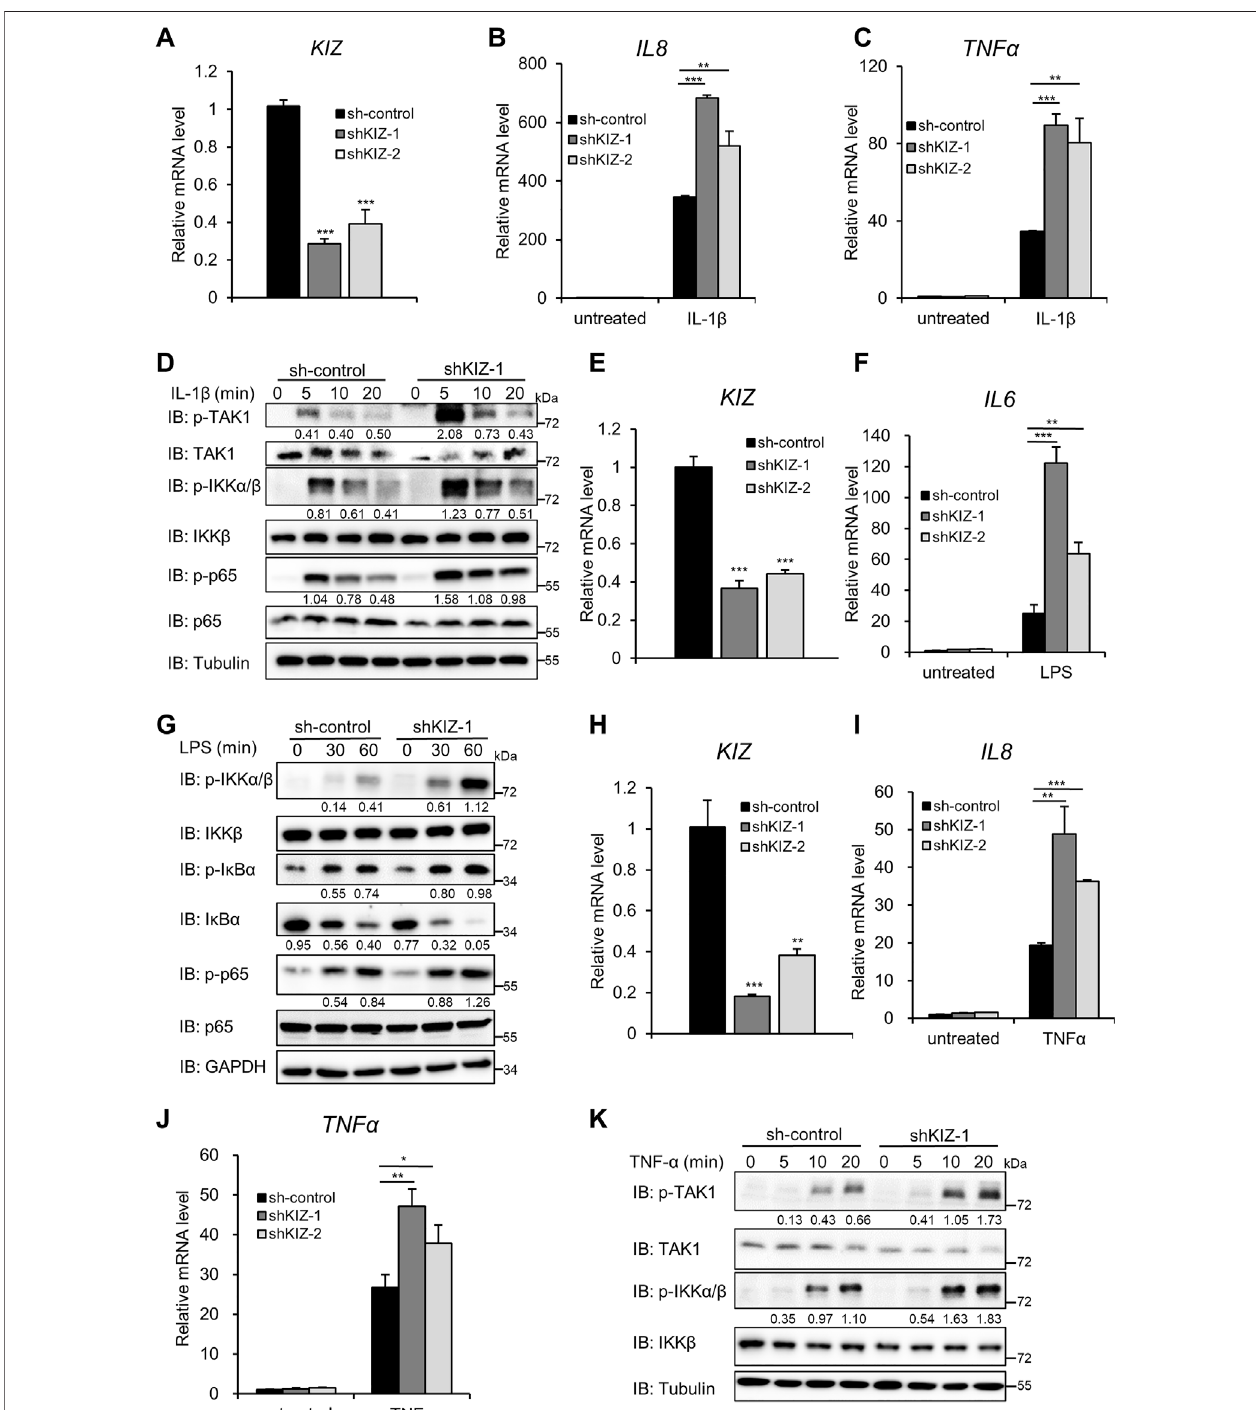
FIGURE 2 | Knockdown of KIZ enhances IL-1 β /LPS/TNF α -induced NF- κ B activation. (A – D) HeLa cells were infected with an shRNA lentivirus that targeted differentcodingregionsof KIZ (shKIZ-1andshKIZ-2)ortheemptyvectorfor48 h.ThecellswerethenuntreatedortreatedwithIL-1 β (20 ng/ml)for3 handthenanalyzed byqPCRtomeasurethemRNAlevelsof KIZ (A) , IL8 (B) ,and TNF α (C) ortreatedfortheindicatedtimes,followedbyimmunoblotting (D) . (E – G) THP1cellswereinfected with a lentivirus that targeted different coding regions of KIZ (shKIZ-1 and shKIZ-2) or the empty vector. After 48 h of infection, the cells were untreated or treated with LPS (1 μ g/ml) for 3 h and then analyzed by qPCR to measure the mRNA levels of KIZ (E) and IL6 (F) or treated for the indicated times, followed by immunoblotting (G) . (H – K) Similar to (A – D) , except the cells were treated with TNF α (20 ng/ml). Data shown in (A – C,E,F,H – J) are from one representative experiment of three independent experiments (mean ± SD, n = 3). * p < 0.05; ** p < 0.01; *** p < 0.001; two-tailed Student ’ s t-test.